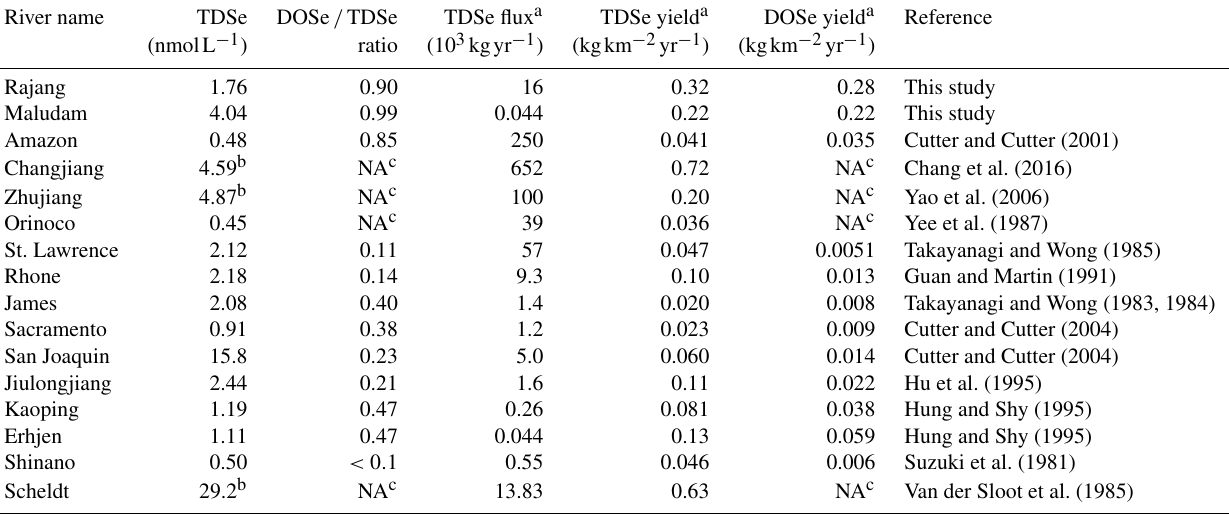
Table 2. Overview of the TDSe concentrations and DOSe / TDSe ratios in the river and the magnitude of riverine TDSe flux and TDSe and DOSe yield to the